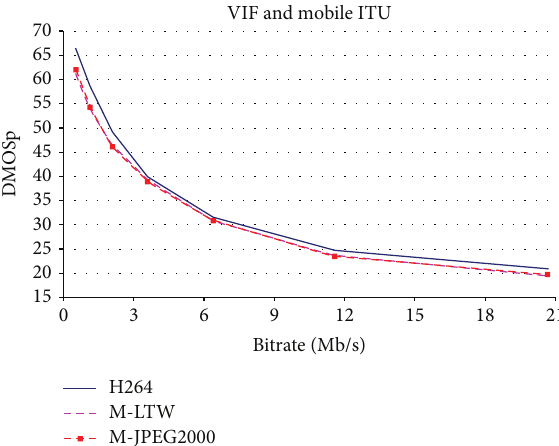
Figure 8: R/D performance evaluation of the three video codecs using mobile ITU video sequence by means of VIF